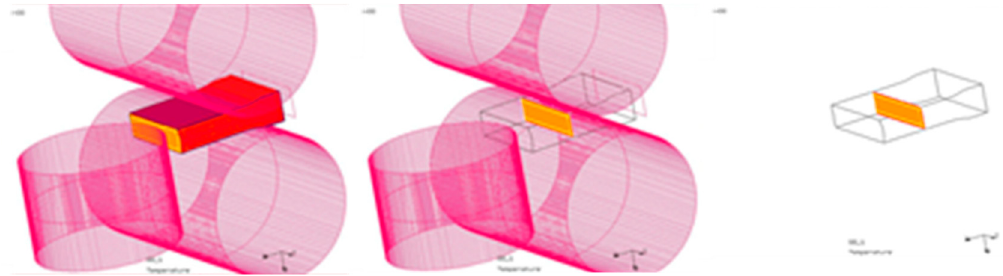
Figure 8. Selection of transversal section of the bar.